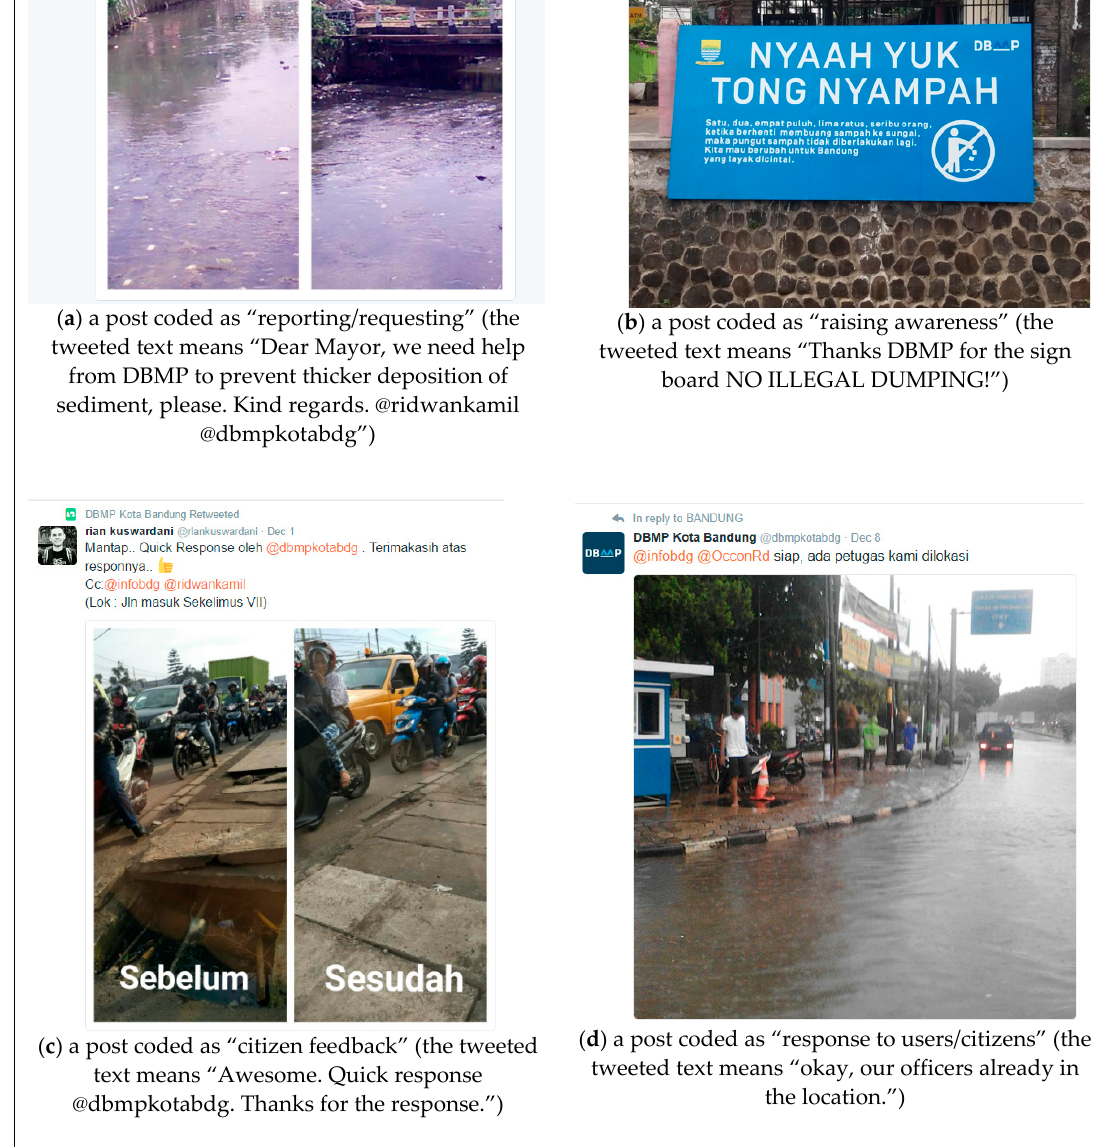
Figure 1. Example of social media posts coded.